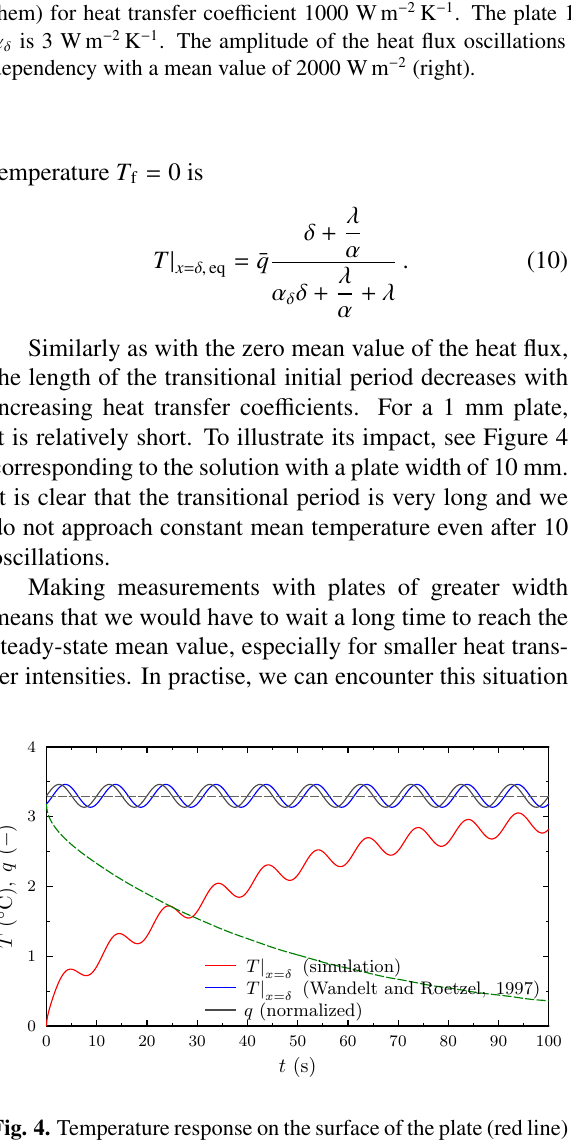
Fig. 4. Temperature response on the surface of the plate (red line) to the harmonic oscillating heat flux (black line), and a compari- son with oscillations corresponding to the Wandelt-Roetzel solu- tion (blue line, and the green dashed line represents the di ff erence between them) for heat transfer coe ffi cient 1000 Wm − 2 K − 1 . The plate 10 mm in width is made from stainless steel. Heat trans- fer coe ffi cient α δ is 3 Wm − 2 K − 1 . The amplitude of the heat flux oscillations is 1000 Wm − 2 , with a mean value of 2000 Wm − 2